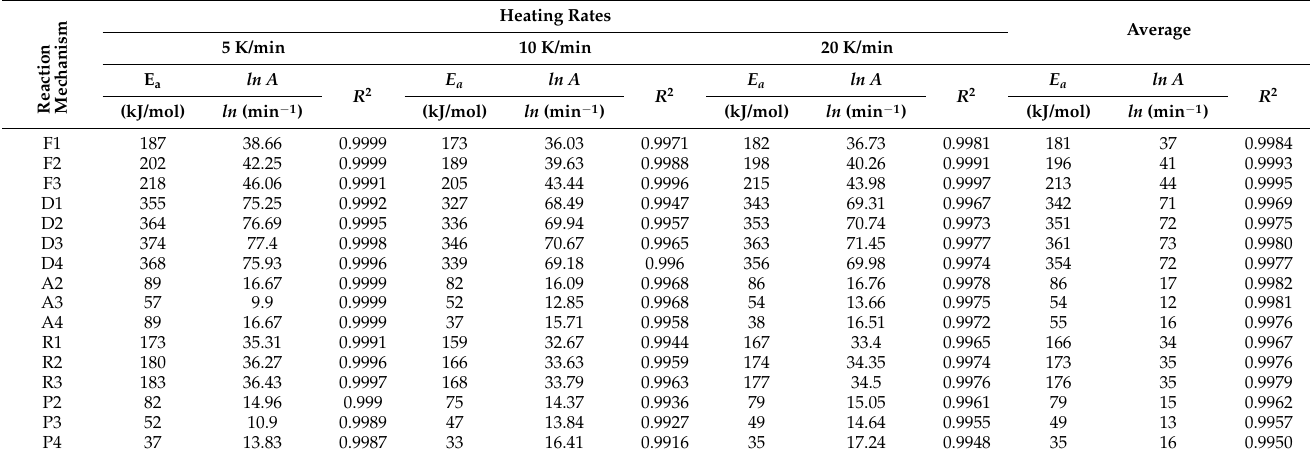
Table 6. Kinetic parameters obtained by Coats-Redfern model for Stage